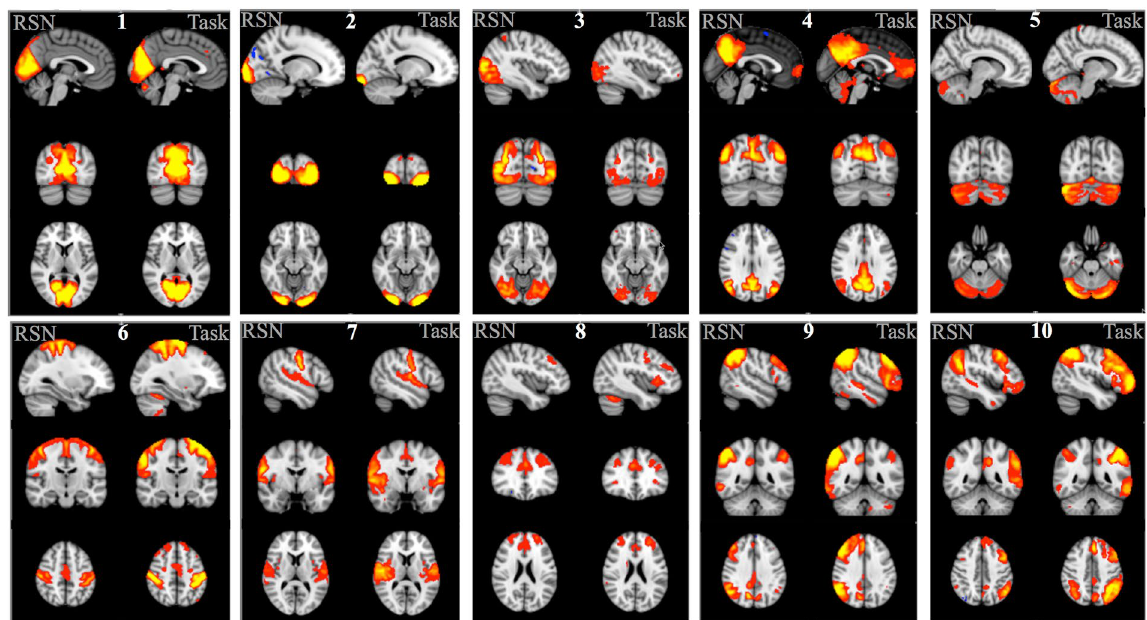
Figure 1. RSNs and task networks (left side and right side of each panel, respectively) from the present study using HCP data that correspond to the ten rest/task networks reported in Smith et al . 30 using standard resting state and BrainMap data. Networks are shown in red-yellow( + )/blue-light blue( − ), thresholded Z = 3.0. Networks are: (1) medial visual, (2) occipital pole, (3) lateral occipital, (4) default mode, (5) cerebellum, (6) sensorimotor, (7) auditory, (8) executive control, (9) right frontoparietal, and (10) left